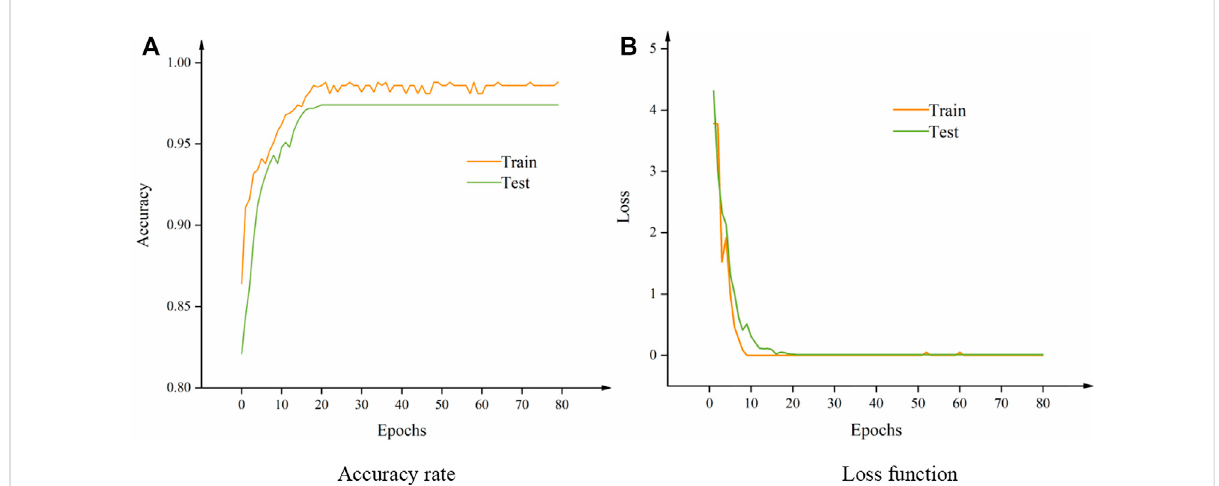
TABLE 1 Performance comparison of three convolution kernel sizes. Size of convolution kernel